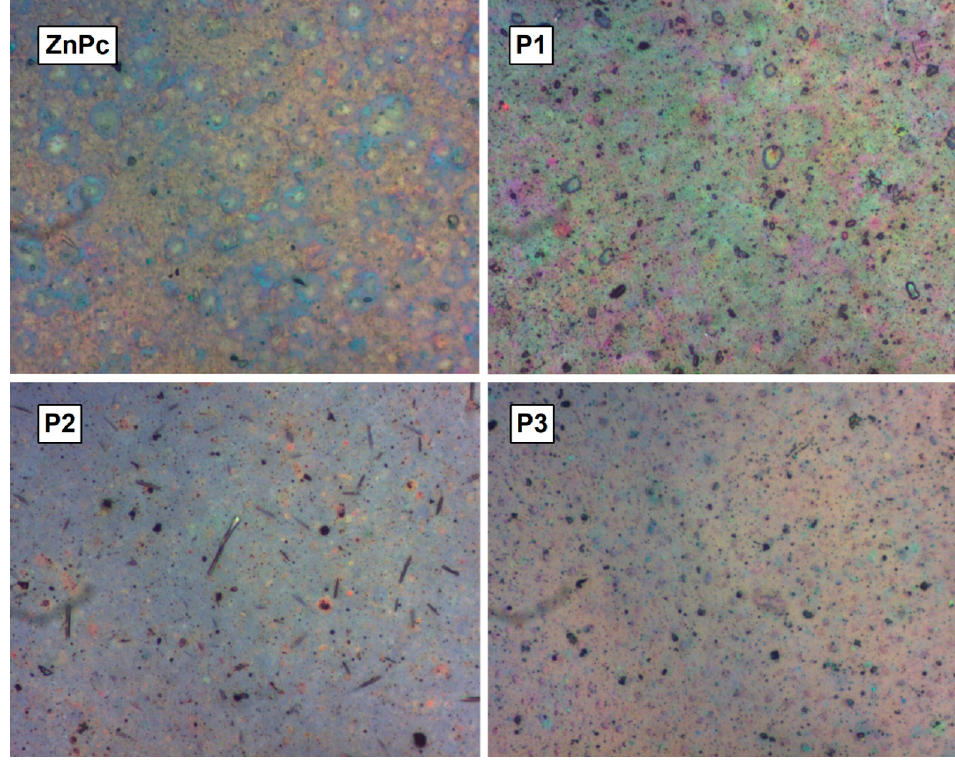
Figure 3. Optical images of the MAPLE-deposited organic layers on glass (500 × 150 × 120 μ m 3 ).